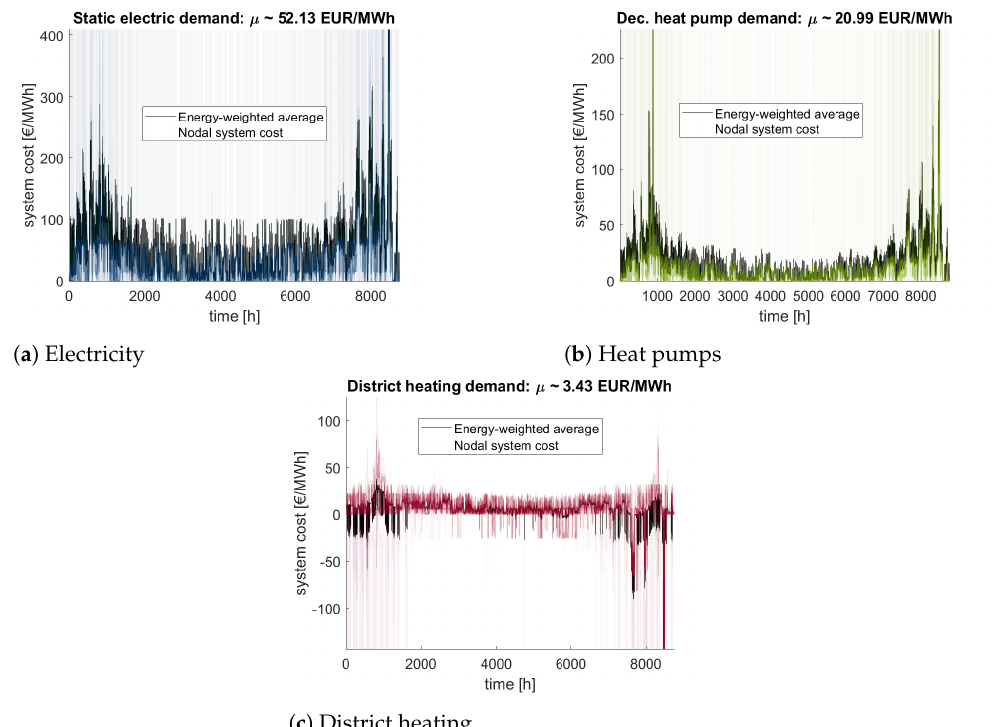
Figure 16. Price curves of nodal demand (in colors) with energy-weighted average in scenario